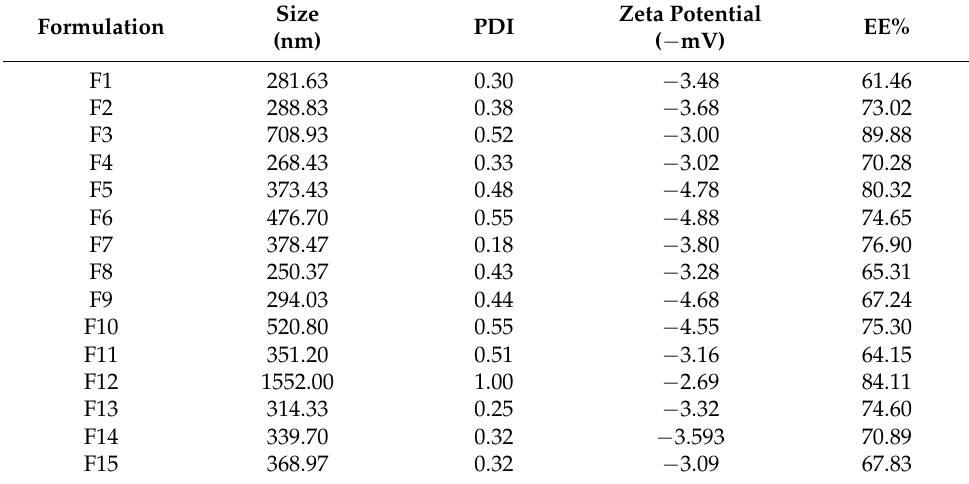
Table 3. Mean size, PDI, zeta potential, and EE% of NPs before yield enhancement.